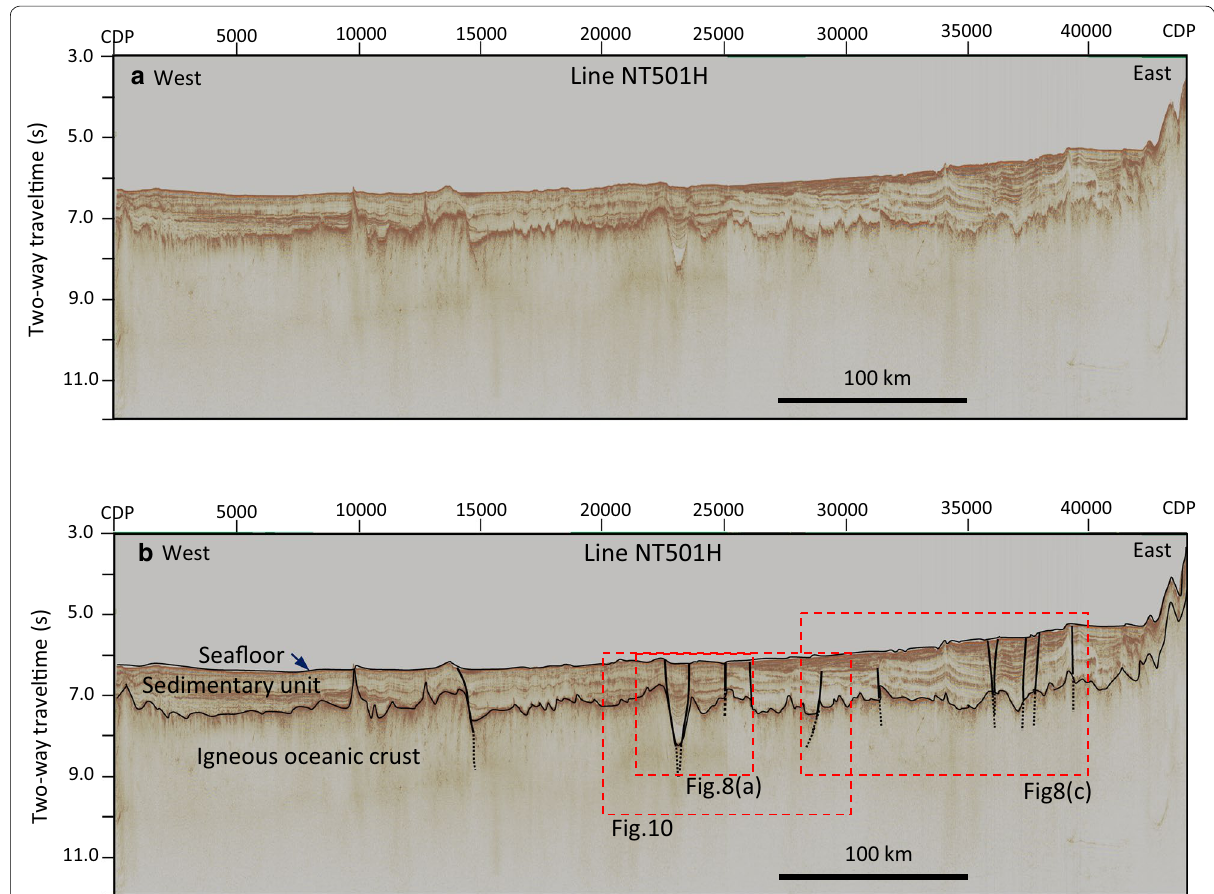
Fig. 2 Seismic reflection profile of the NT501H line. The post‑stack time migration profile is shown in the top panel ( a ), and the profile with fault interpretation in the bottom panel ( b ). The horizontal axes of the figures represent CDP numbers, and the vertical axes indicate two‑way travel time in seconds. Rectangles with red broken lines mark the areas expanded in Figs. 8a, c and 10. Several faults can be interpreted by offsetting of reflec‑ tions in the sedimentary